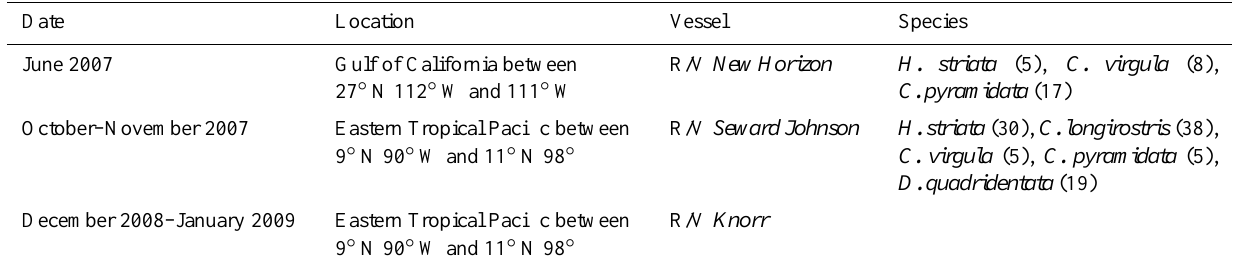
Table 1. Dates, locations, vessels used and species collected for physiological experiments during